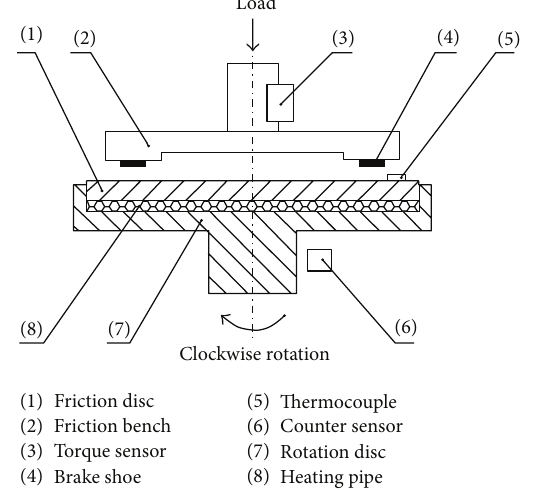
Figure 1: Schematic of the X-DM friction